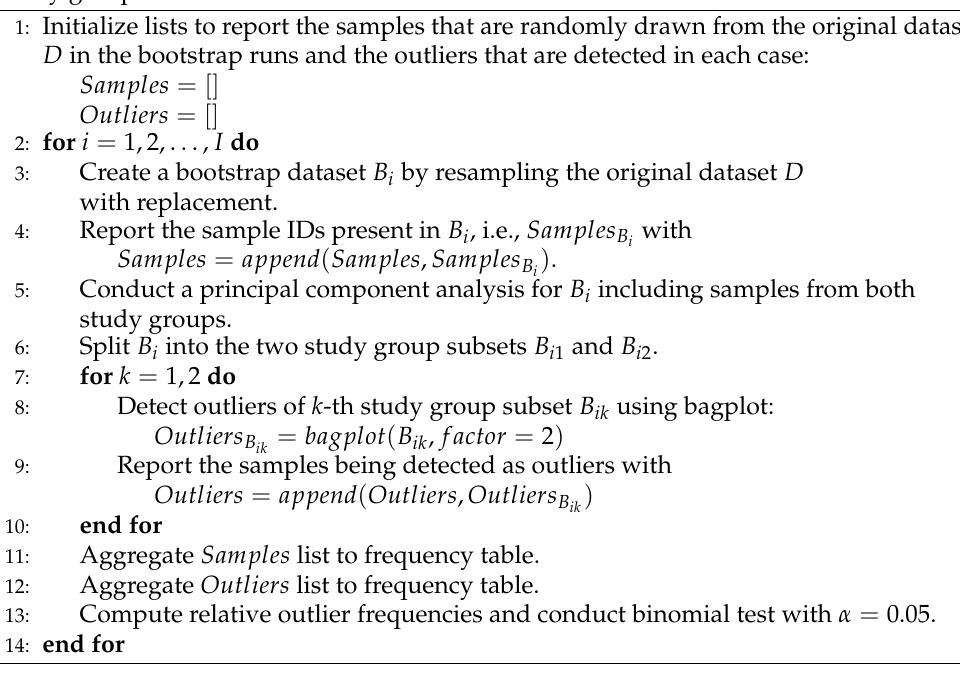
Algorithm 1 Pseudo-code of bootstrap–bagplot algorithm for outlier detection for two study groups.